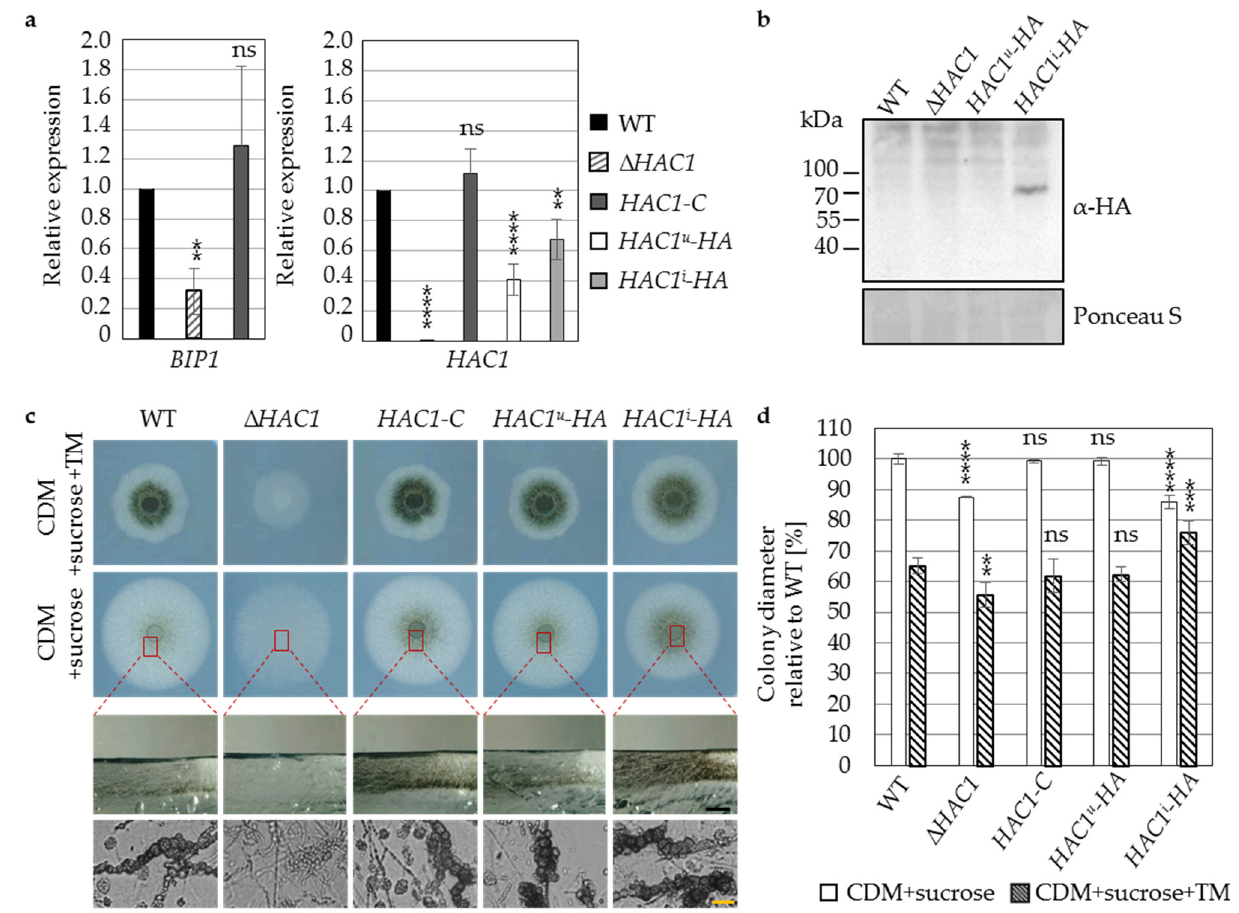
Figure 2. Verticillium dahliae HAC1 supports growth and is essential for microsclerotia formation. V. dahliae wildtype (WT), HAC1 deletion ( ∆ HAC1 ), and complementation ( HAC1-C ) strains, as well as strains expressing ectopically integrated HAC1 mRNA splice variants fused to HA at the 3 ′ -end in the ∆ HAC1 strain ( HAC1 u -HA ; HAC1 i -HA ) were compared. ( a ) Quantification of BIP1 (left) and HAC1 (right) gene expression levels. Primers targeting BIP1 or both HAC1 mRNA splice variants were used. Bars represent mean values normalized to wildtype with H2A and EIF2B as references with standard deviations. (Significant differences to wildtype: ** p < 0.01; **** p = 0; ns = non-significant; n ≥ 3.) HAC1 u -HA and HAC1 i -HA show reduced HAC1 gene expression levels. ( b ) Immunoblot of Hac1 proteins in HAC1 u -HA and HAC1 i -HA . HA-specific antibody and Ponceau S staining as loading control were used. For HAC1 i -HA producing unconventionally spliced HAC1 mRNA only, a signal is visible at ~70 kDa for tagged Hac1 instead of the predicted 46 kDa. In both strains no specific band was observed for the predicted Hac1 u -HA protein (59 kDa). ( c ) Microsclerotia formation ex planta. Except ∆ HAC1 , all strains form wildtype-like microsclerotia 10 d after spot inoculation on CDM with sucrose with or without tunicamycin (TM = 1 µ g/mL). For ∆ HAC1 neither melanized nor unmelanized microsclerotia are visible in cross sections of the colony centers (red boxes/dashed lines) or microscopy of fungal material (bottom). HAC1-C and HAC1 i -HA strains produce increased levels (Black scale bar = 1 mm, yellow scale bar = 20 µ m). ( d ) Quantification of vegetative growth 10 d after spot inoculation. ∆ HAC1 displays reduced growth. HAC1-C and HAC1 u -HA display wildtype-like growth, whereas growth of HAC1 i -HA is decreased under non-stress conditions and increased upon supplementation of TM. Mean values of three independent experiments relative to wildtype on CDM with sucrose and standard deviations are shown. (Significant differences to wildtype on respective media: ** p < 0.01; *** p < 0.001 **** p = 0, ns = non-significant, n ≥